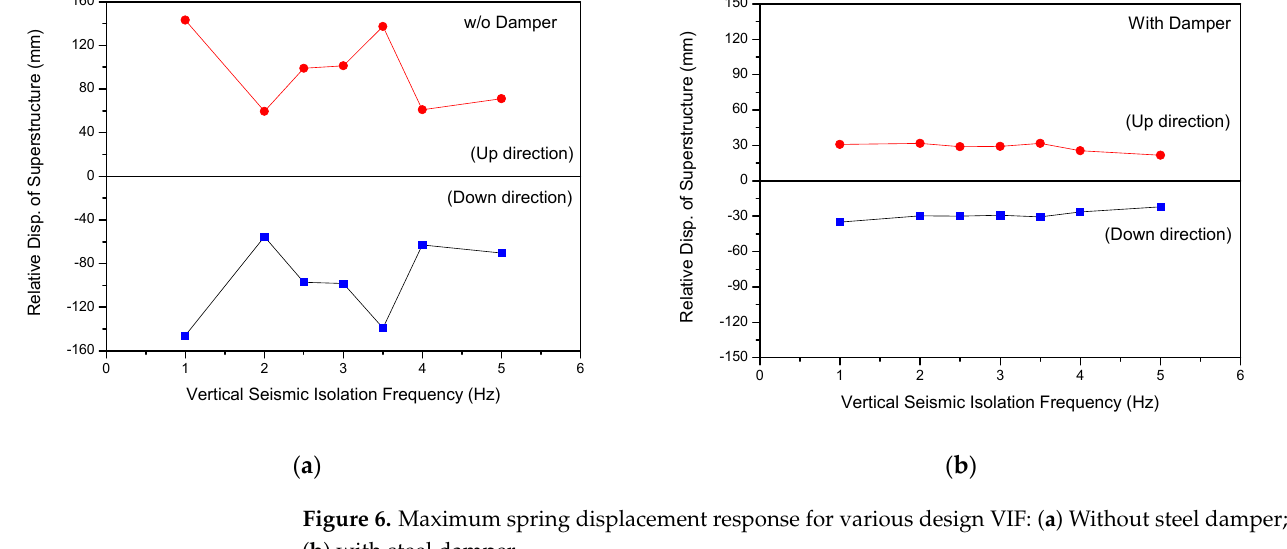
Figure 6. Maximum spring displacement response for various design VIF: ( a ) Without steel damper; ( b ) with steel damper.